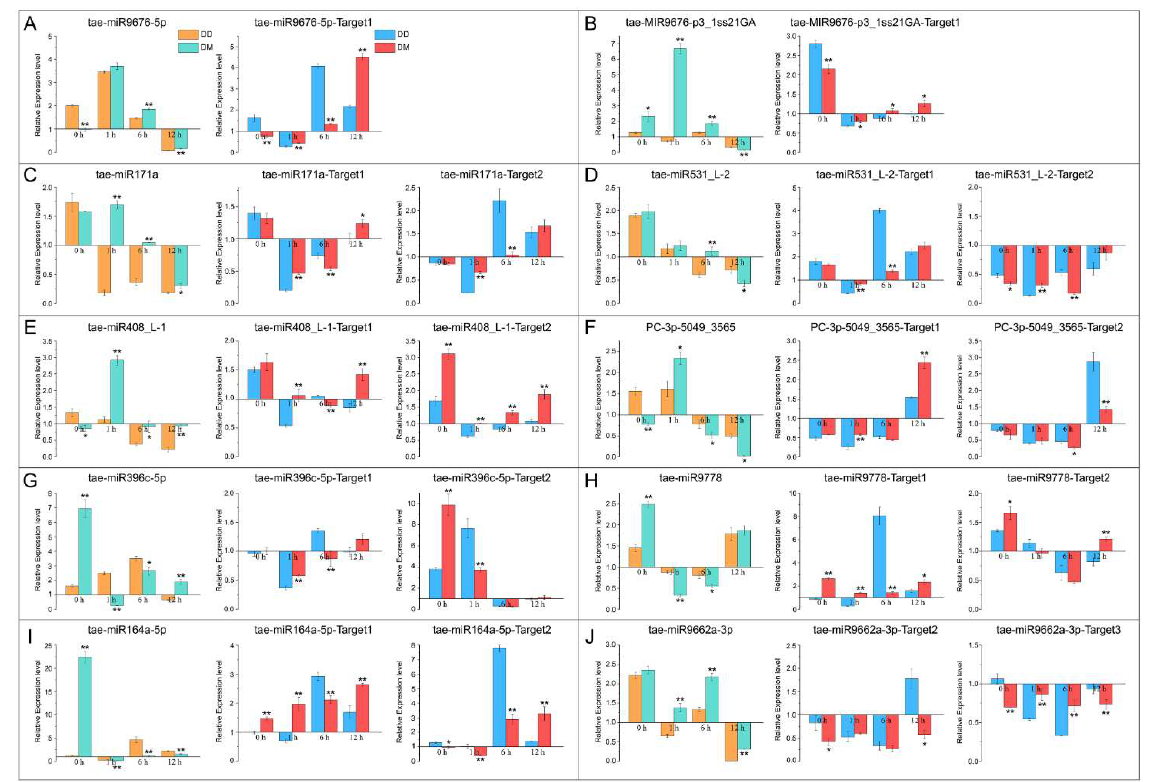
Figure 3. Validation of 10 drought memory-related miRNAs and their target genes by RT-qPCR. ( A – J ) The relative expression level of ten candidate drought memory-related miRNAs and their target genes. The relative expression level of each miRNA and their target genes was compared between DD and DM groups at 0, 1, 6, and 12 h, with the CG as control. The expression levels of the miRNAs and target genes were normalized using U6 (GenBank: X63066.1) and Elongation Factor 1-Alpha genes, respectively. All reactions were performed in triplicate for each sample, and expression levels were calculated according to the 2 − ∆∆ CT method. Error bars represent the SD, * p < 0.05; ** p <